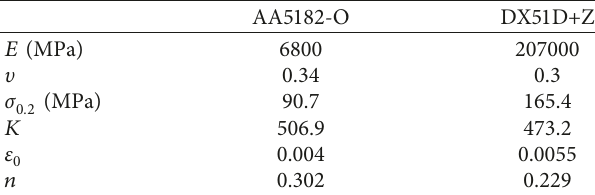
Table 1: Mechanical properties of AA5182-O and